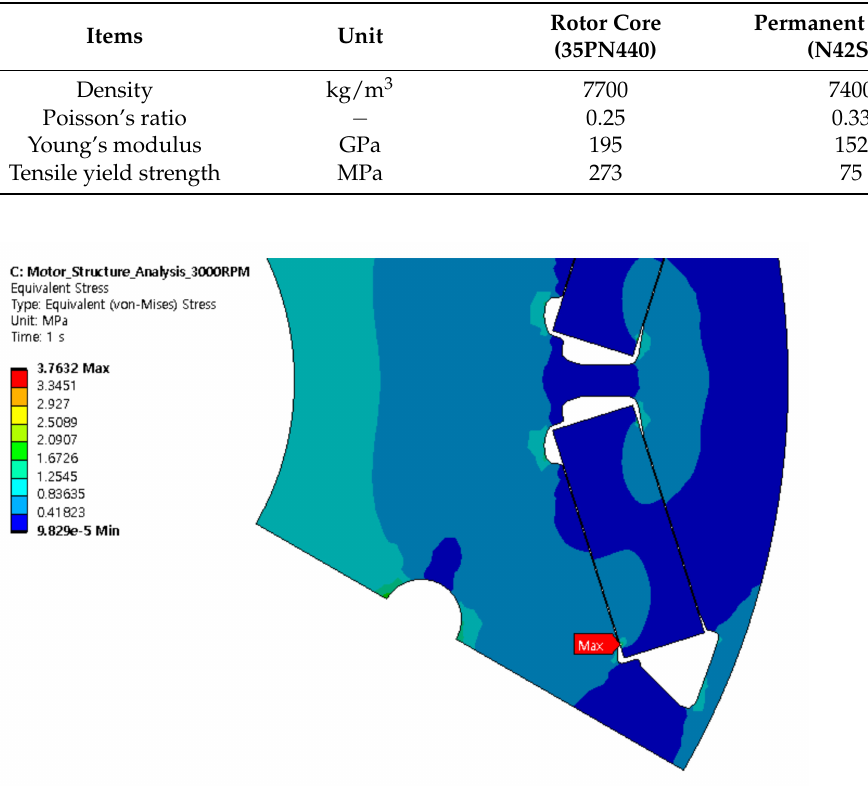
Figure 7. Mechanical stress analysis